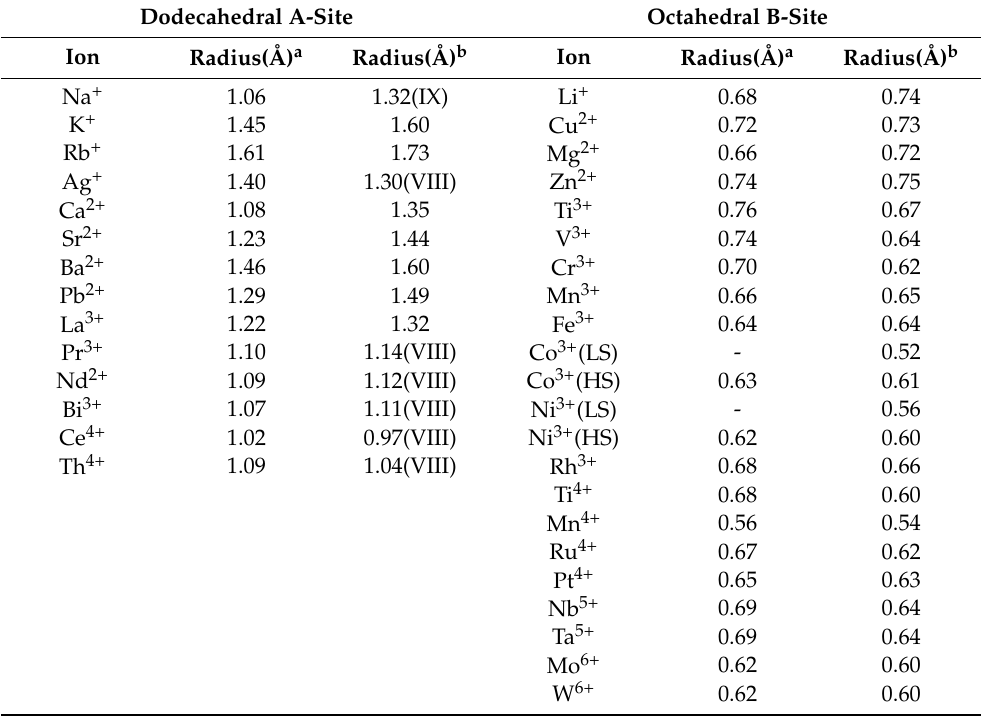
Table 1. Cations for ABO 3 -type perovskites, with their respective radii [7,22]. Dodecahedral A-Site Octahedral